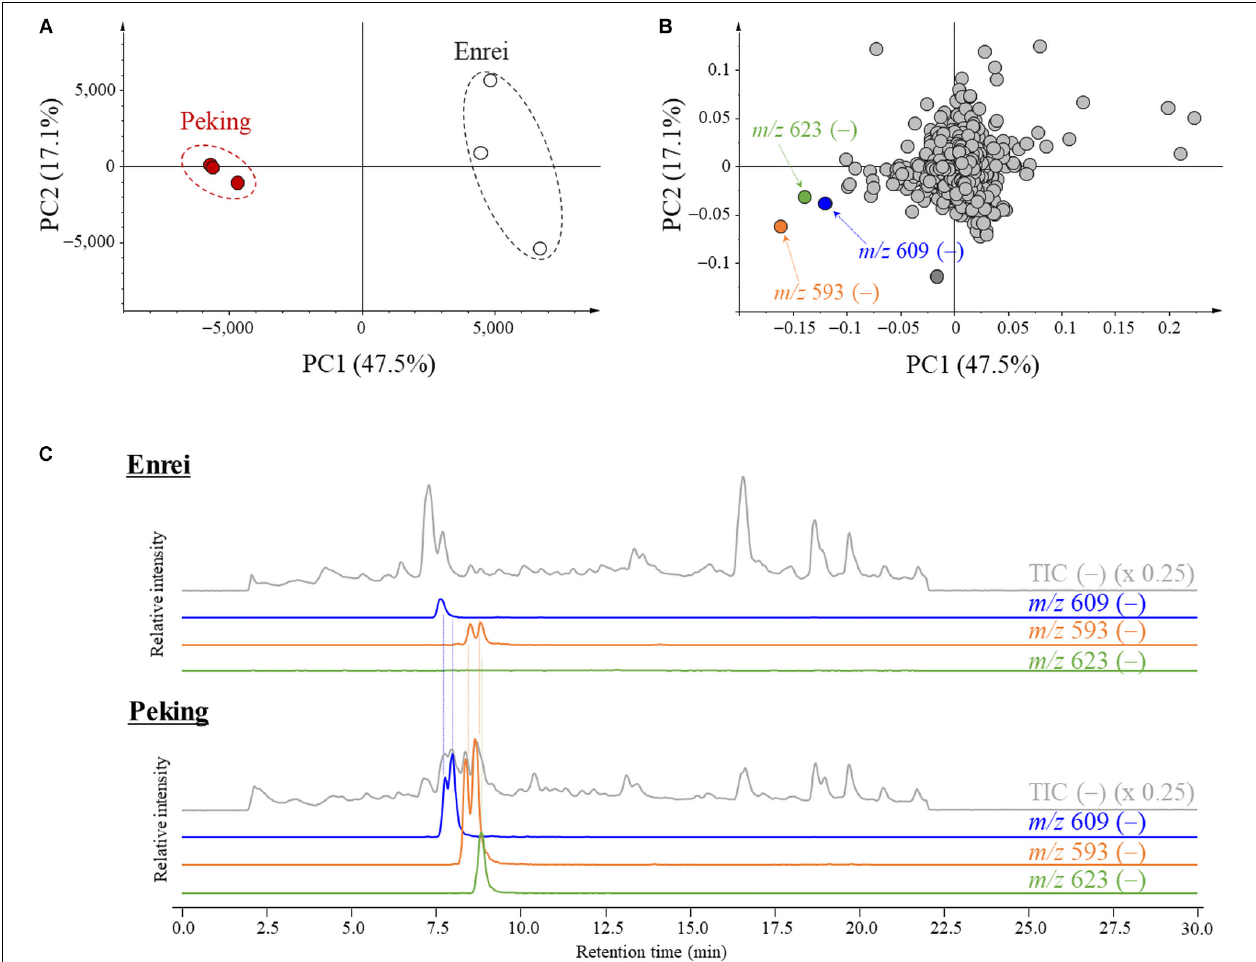
FIGURE 2 | Principal component analysis (PCA) plots and liquid chromatography-mass spectrometry (LC-MS) chromatograms of metabolites isolated from Peking and Enrei. (A) PCA score plot. Red circles and white circles indicate Peking and Enrei, respectively ( n = 3). (B) PCA loading plot. Components with large negative loading values are indicated by orange, green and blue circles. The m/z value and polarity of each component are described. (C) LC-MS chromatograms of Enrei and Peking leaf extracts. Total ion chromatograms (TIC) and extracted ion chromatograms (XIC) are described with the m/z value and the fold. Two peaks of m/z 609, two peaks of m/z 593 and one peak of m/z 623 were strongly detected in